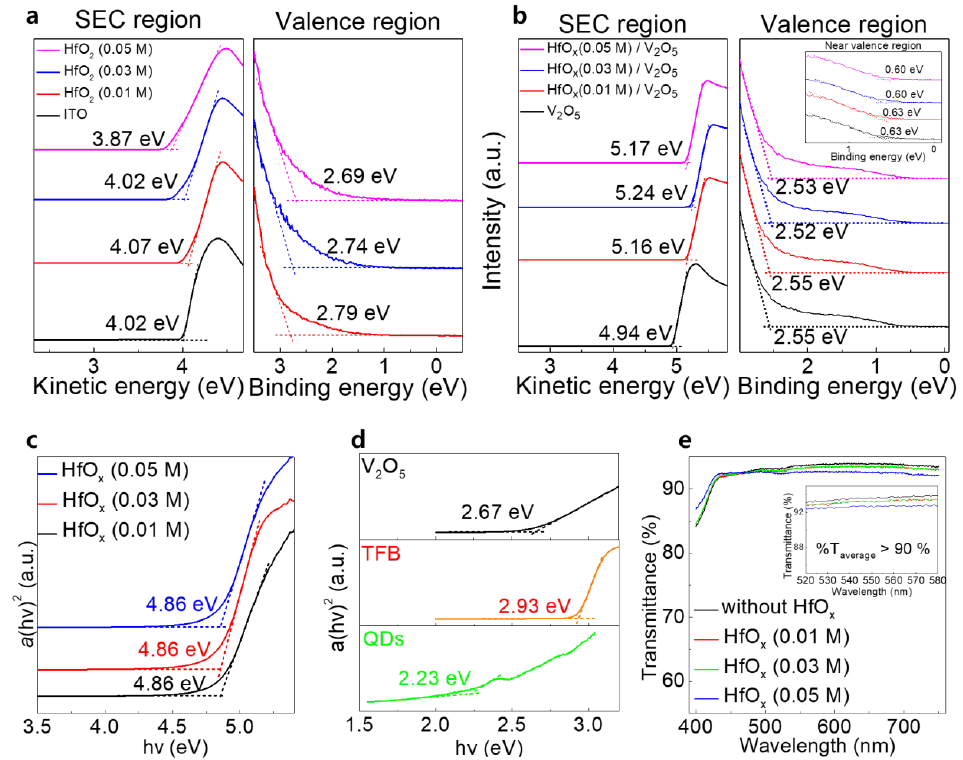
Figure 2. SEC and valence region spectra of ( a ) ITO, HfO x (0.01 M), HfO x (0.03 M), and HfO x (0.05 M) films; and ( b ) V 2 O 5 , HfO x (0.01 M)/V 2 O 5 , HfO x (0.03 M)/V 2 O 5 , and HfO x (0.05 M)/V 2 O 5 films. The inset shows the near valence region spectra of each of the films. Tauc plots of the ( c ) HfO x (0.01 M), HfO x (0.03 M), and HfO x (0.05 M) films; and ( d ) V 2 O 5 , TFB, and QDs. ( e ) Optical transmittance spectra of glass/V 2 O 5 /TFB/QDs/ZnO films with and without the HfO x layer. figfig:materials-2102600-f004a − d shows the deconvoluted V 2p 3/2 XPS profiles for the V 2 O 5 , and HfO x (0.01, 0.03, and 0.05 M)/V 2 O 5 films, respectively. The V 2p 3/2 spectrum